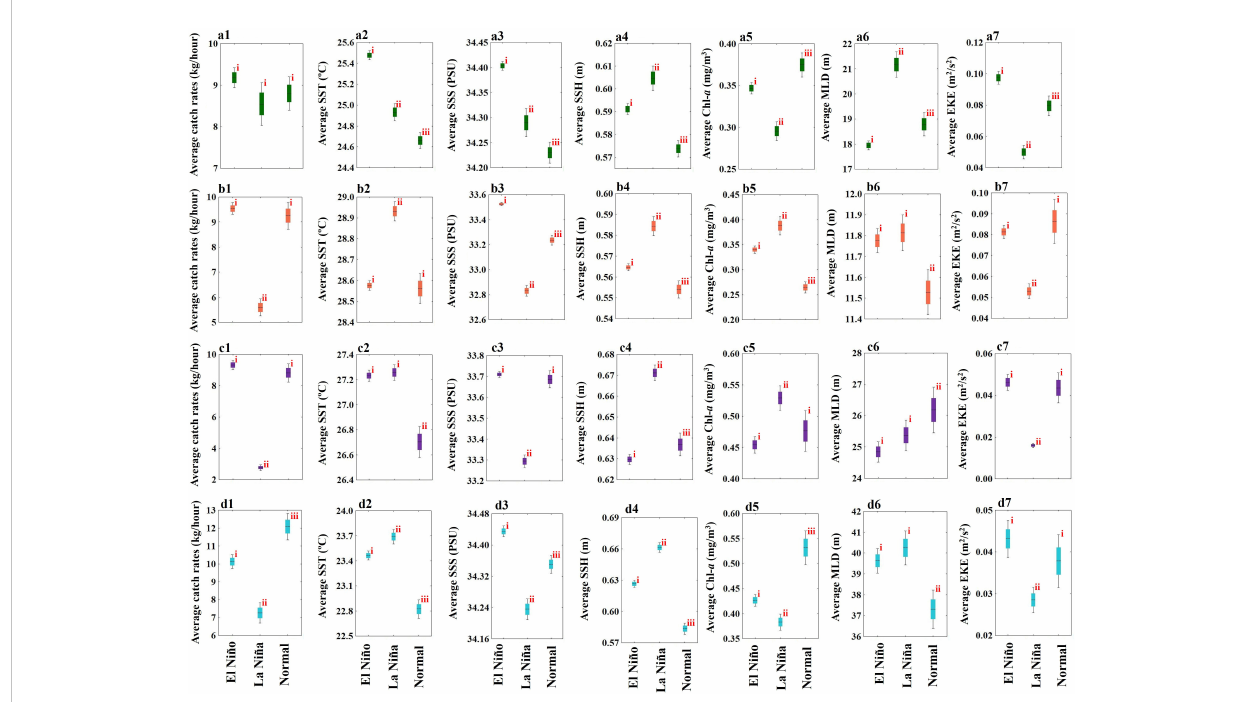
FIGURE 7 The box-and-whisker plots illustrating the effect of the environmental variables on catch rates for greater amberjack in spring (A1 – A7) , summer (B1 – B7) , autumn (C1 – C7) , and winter (D1 – D7) during ENSO events in the Taiwan Strait. The height of the box is equivalent to the standard error, and horizontal black line indicates the mean. The superscripted roman numerals denote the signi fi cant differences identi fi ed using the Tukey ’ s test ( p < 0.05). One-way analysis of variance was utilized to determine the signi fi cant differences of each